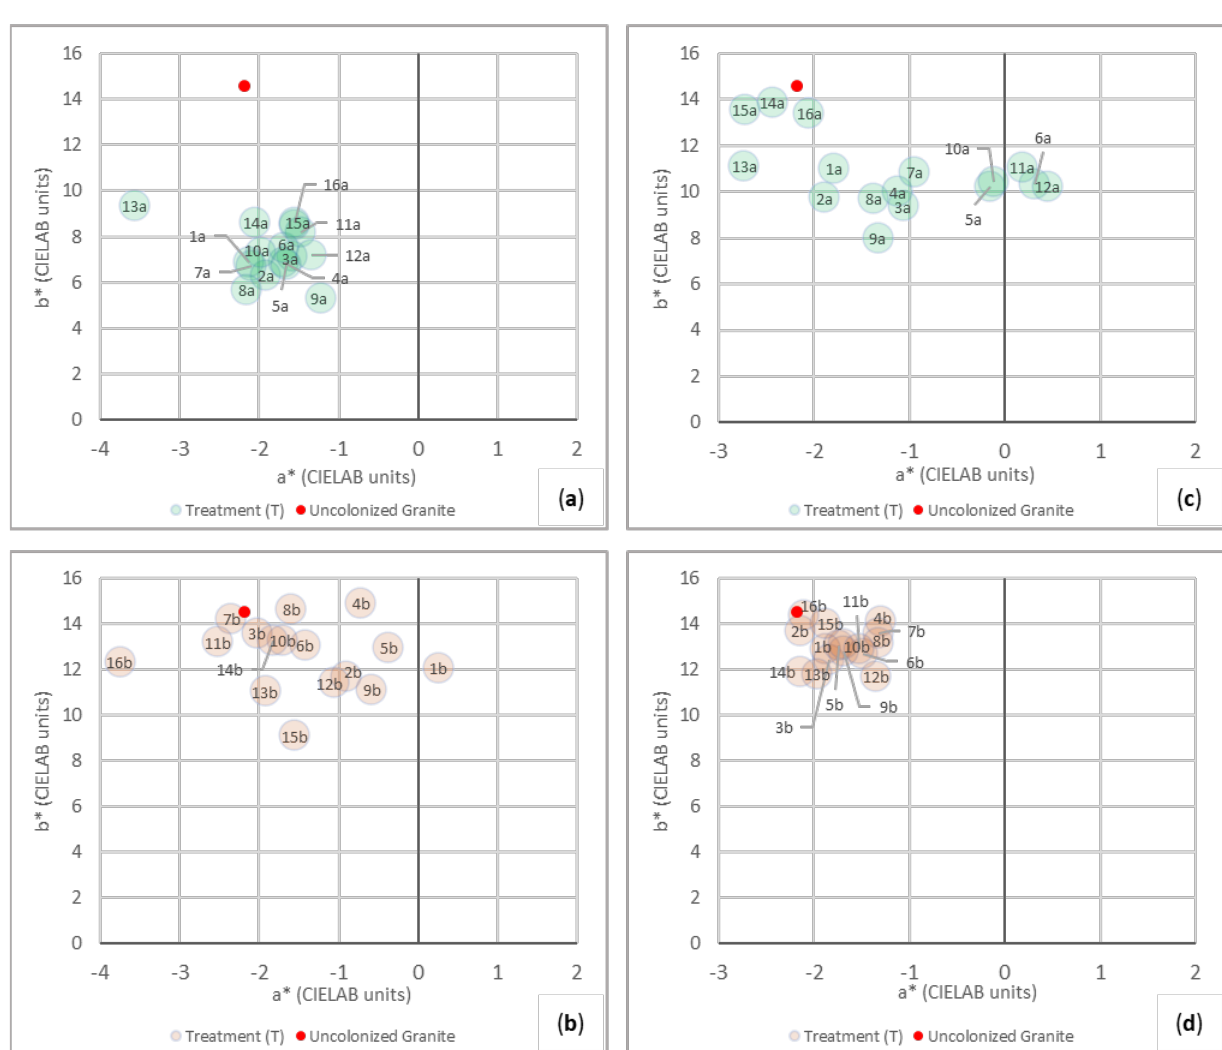
Figure 7. Color changes of the samples from Surface a and Surface b, before (t 0 ) and after (t 1 ) the treatment’s removal, are reported in the colorimetric plane of a* (x-axis, changes in redness-greenness) and b* (y-axis, changes in yellowness-blueness). ( a ) Color data from Surface a at t 0 ; ( b ) color data from Surface b at t 0 ; ( c ) color data form Surface a at t 1 ; ( d ) color data from Surface b at t 1 . In each graph, the color of the reference value for the uncolonized granite was also represented (red spot). Each number represents the corresponding treatment (codes are shown in Figure 3), and the letters (a and b) correspond to the surface where the treatments have been applied.